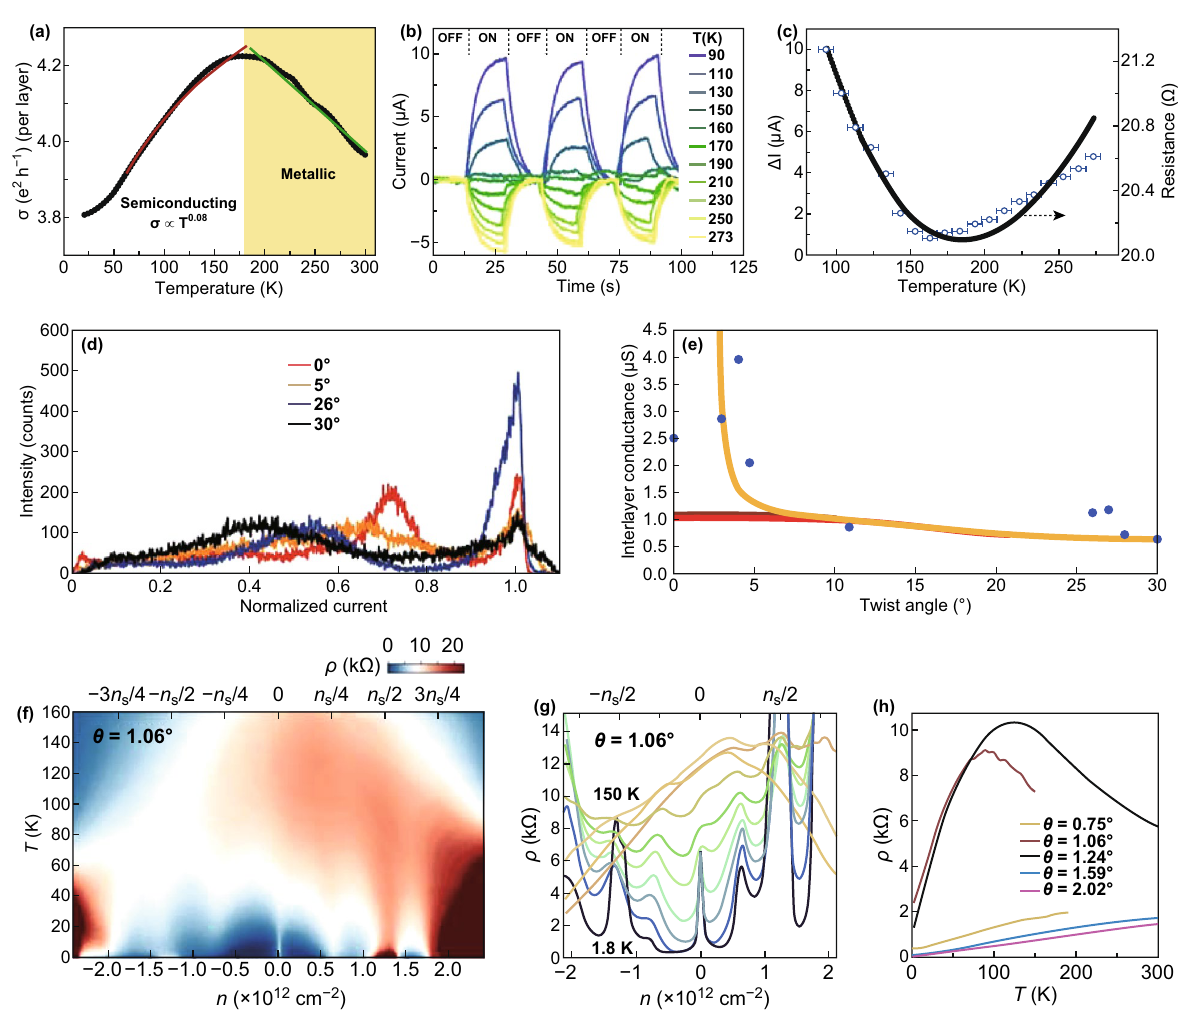
Fig. 8 a Variation in temperature-dependent conductivity, σ , of the tMLG device at 90 K to 273 K temperature range, and blue and red lines are power law and linear fit to the curves in the metallic region and semiconducting region, respectively. b Temporal variation in the photocurrent with the intermittent enlightenment of light source measured at 50 mV. c Photoresponse variation indicated by the varying of the current (left) and the resistance (right), measured at different temperatures [134]. d Normalized current distributions of four tBLG domains with different twisting angles. e Interlayer conductance of tBLG with different twisting angles. The orange curve and the red curve indicate a phonon-assisted transport mechanism with and without considering the renormalization of the Fermi velocity, respectively [135]. f Temperature-dependent resis- tivity ( ρ ) of tBLG device. g Resistivity ( ρ ) as a function of carrier density at selected temperatures in tBLG device, h ρ ( T ) recorded in tBLG devices with different twisting angles near − n s /2 filling [137]. Adapted with permission from Refs. [134, 135,